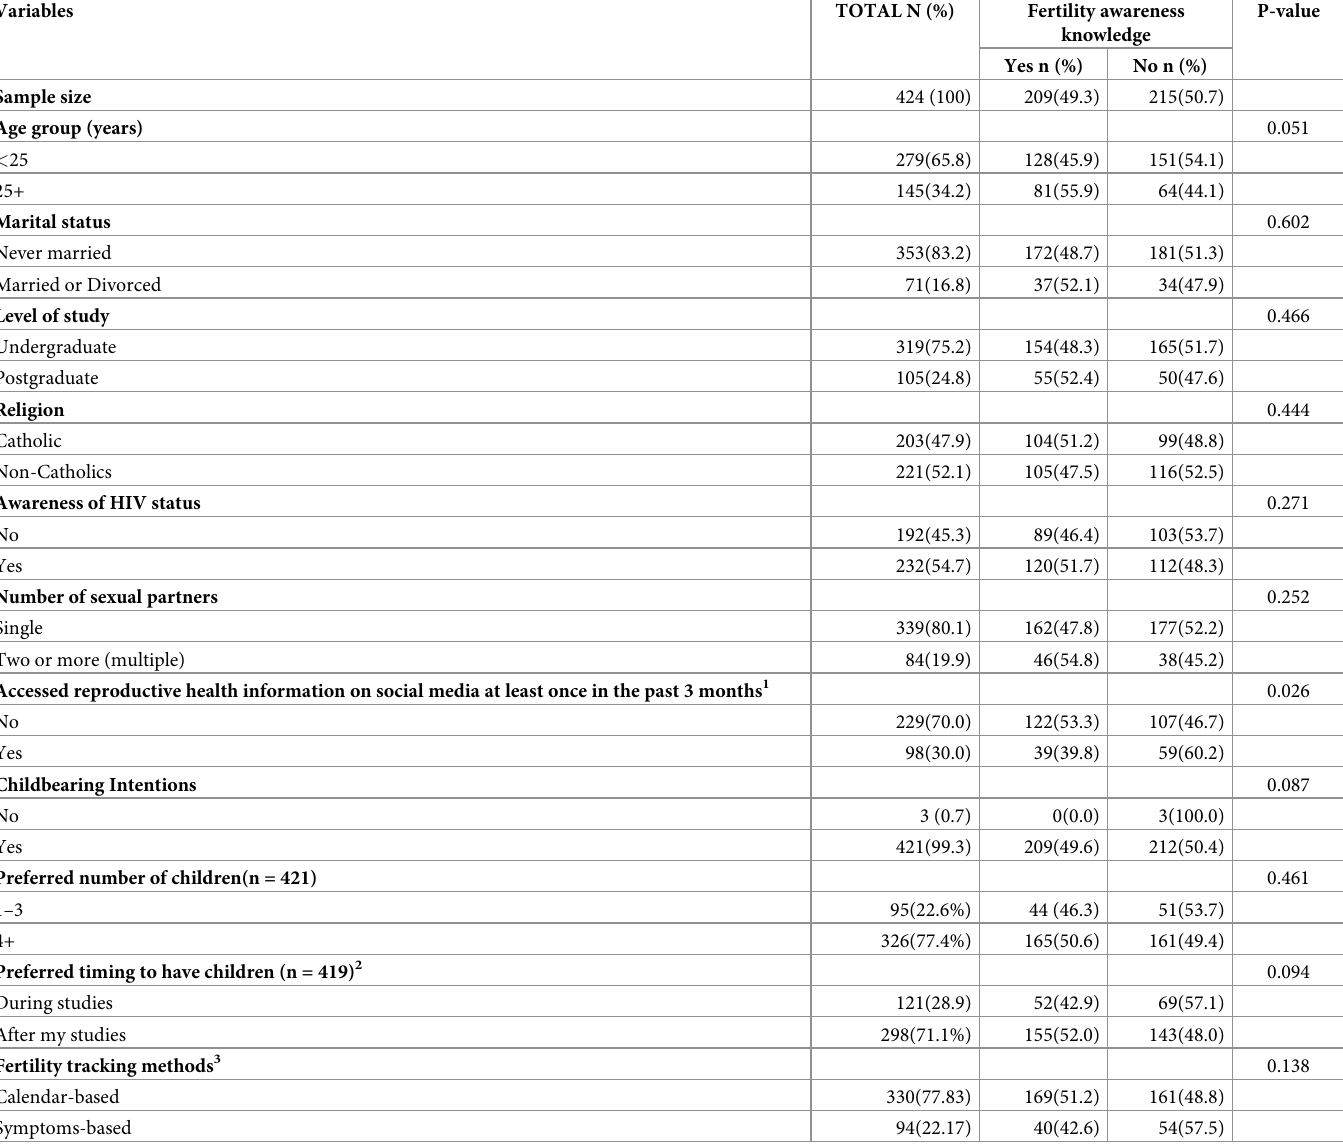
Table 1. Demographic & fertility related characteristics by fertility awareness